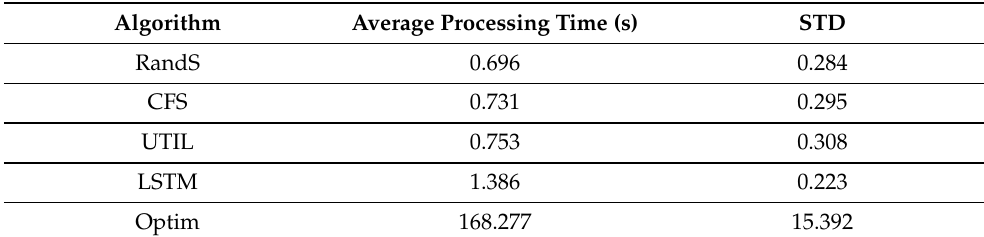
Table 4. Average processing time of